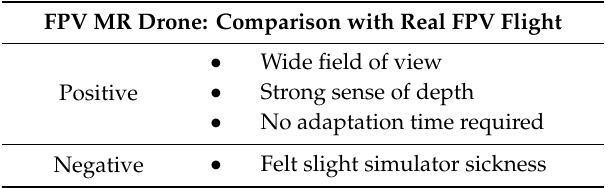
Figure 11. A pilot controlling a drone using the proposed system and the scene from the user's point of view. Table 2. Comparison of FPV control in real and mixed reality.